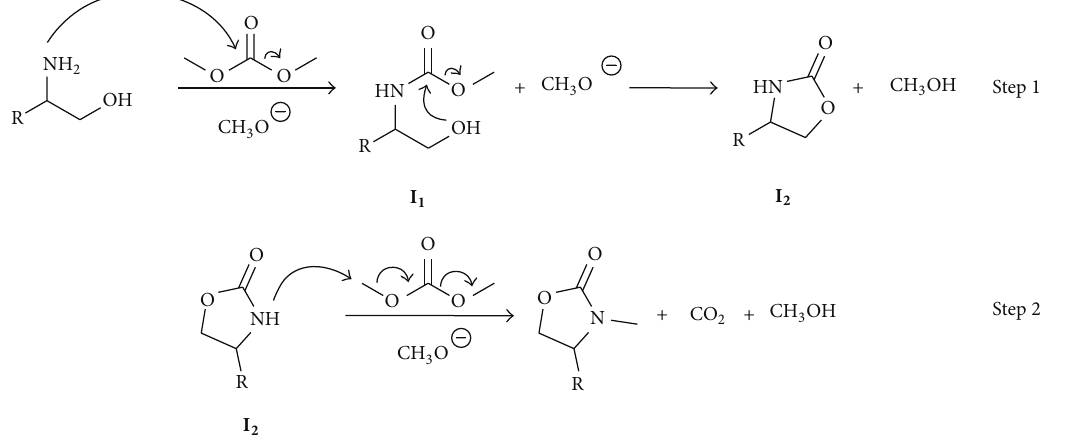
Scheme 7: Plausible mechanism for cyclization of amino alcohols using TBAC and